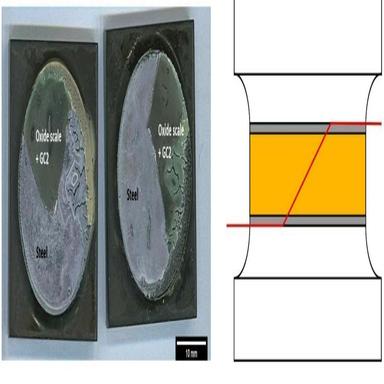
(a,b) typical polished cross-sections and (c) typical fracture surface after torsion for both THG-5 and THG-25 glass-ceramic 2 (GC2) joined samples after test at room temperature (τ = 49 ± 10 MPa and τ = 51 ± 17 MPa, respectively) (pictures refer to THG-25); (d) fracture propagation sketch (orange = glass-ceramic; grey = oxide scale; red = fracture propagation): mixed behavior, with GC2 partially present on both fracture surface, as verified in (e) by SEM-EDS, with each region identified (For interpretation